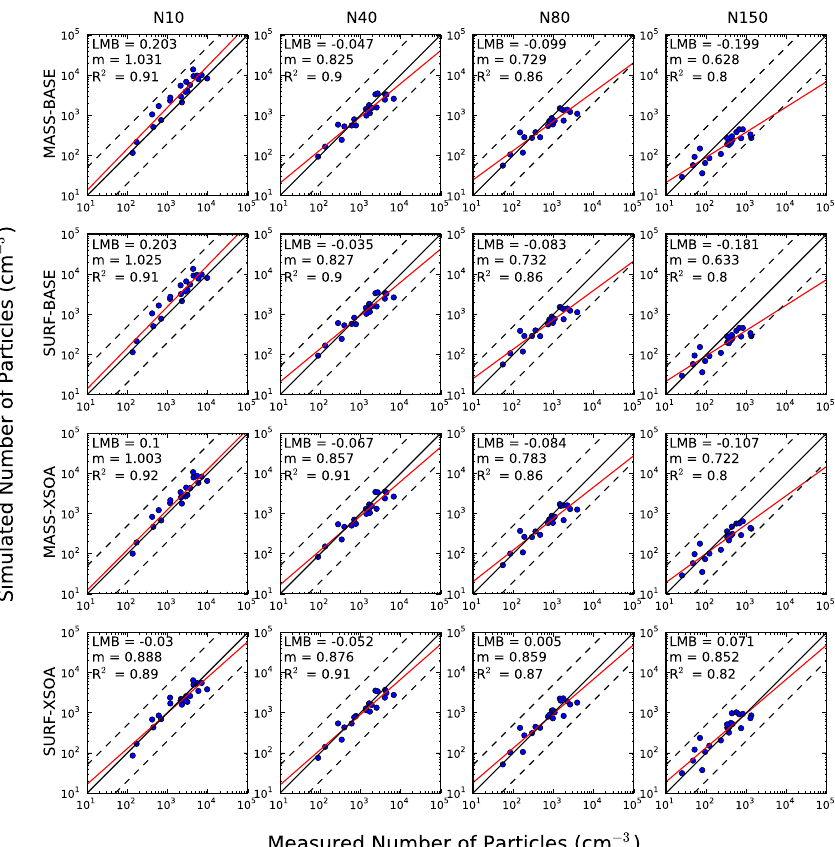
Fig. 9. 1:1 plots for measured and simulated annual-mean N10, N40, N80 and N150 (the total number of particles with diameter larger than 150nm), calculated log-mean bias (LMB), slope of the linear regression ( m ), and correlation ( R 2 ). The dashed black lines indicate 5:1 and 1:5 lines. The simulations with the sub-20nm growth rate parameterizations (SURF-XSOA-K and SURF-XSOA-H) were withheld from this figure. A summary of the statistics is compiled in Table 3.